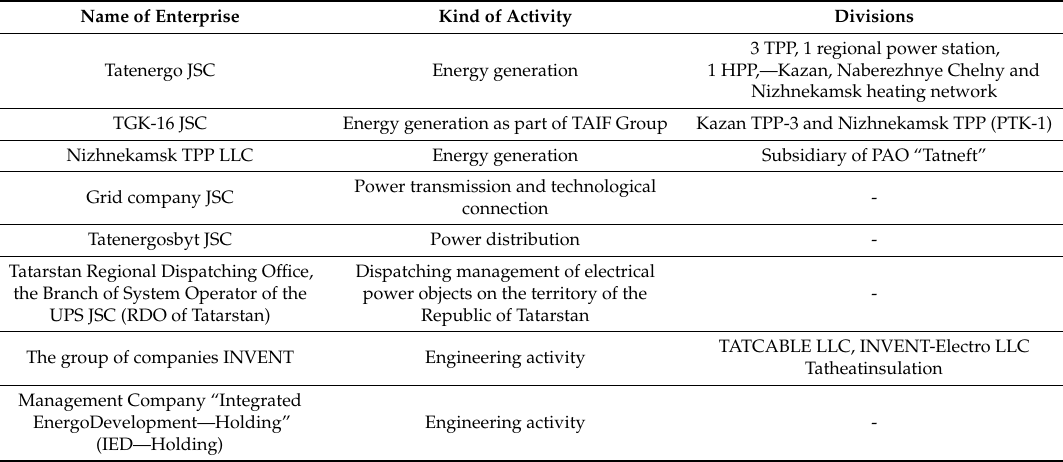
Table 1. Leading enterprises of the energy sector in the Republic of Tatarstan